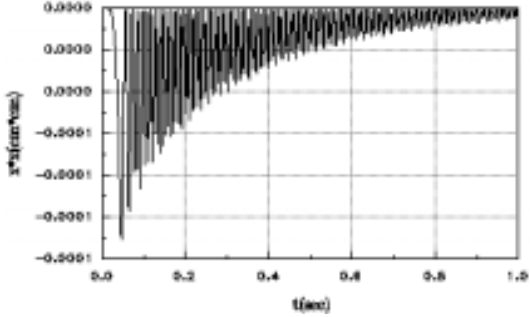
Fig. 2. The mean displacement x 1 .